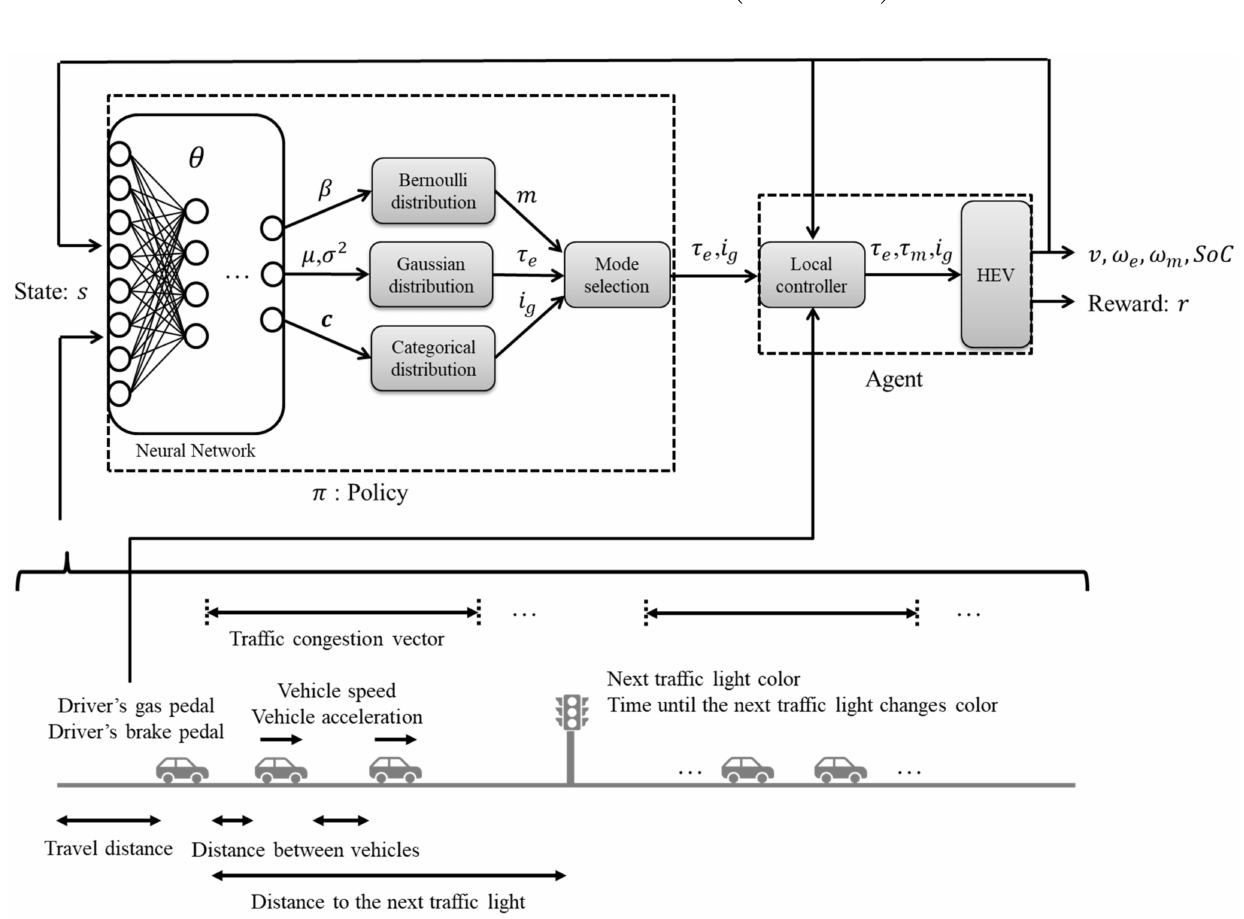
Figure 2. Structure of control